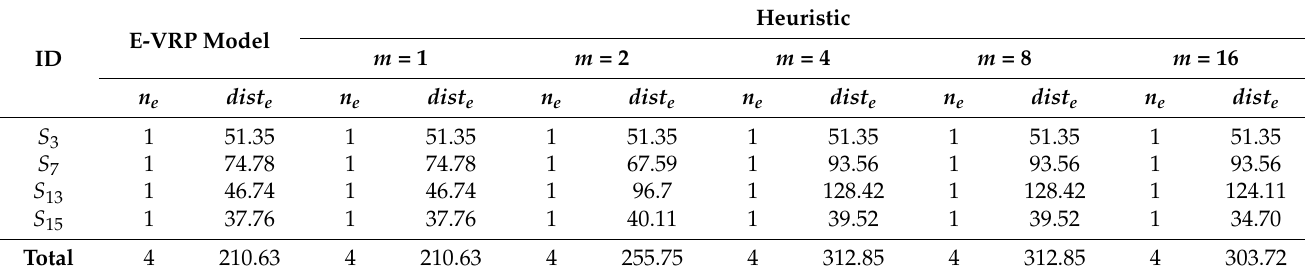
Table 3. E-VRP and heuristic of EV routing for small-sized instance